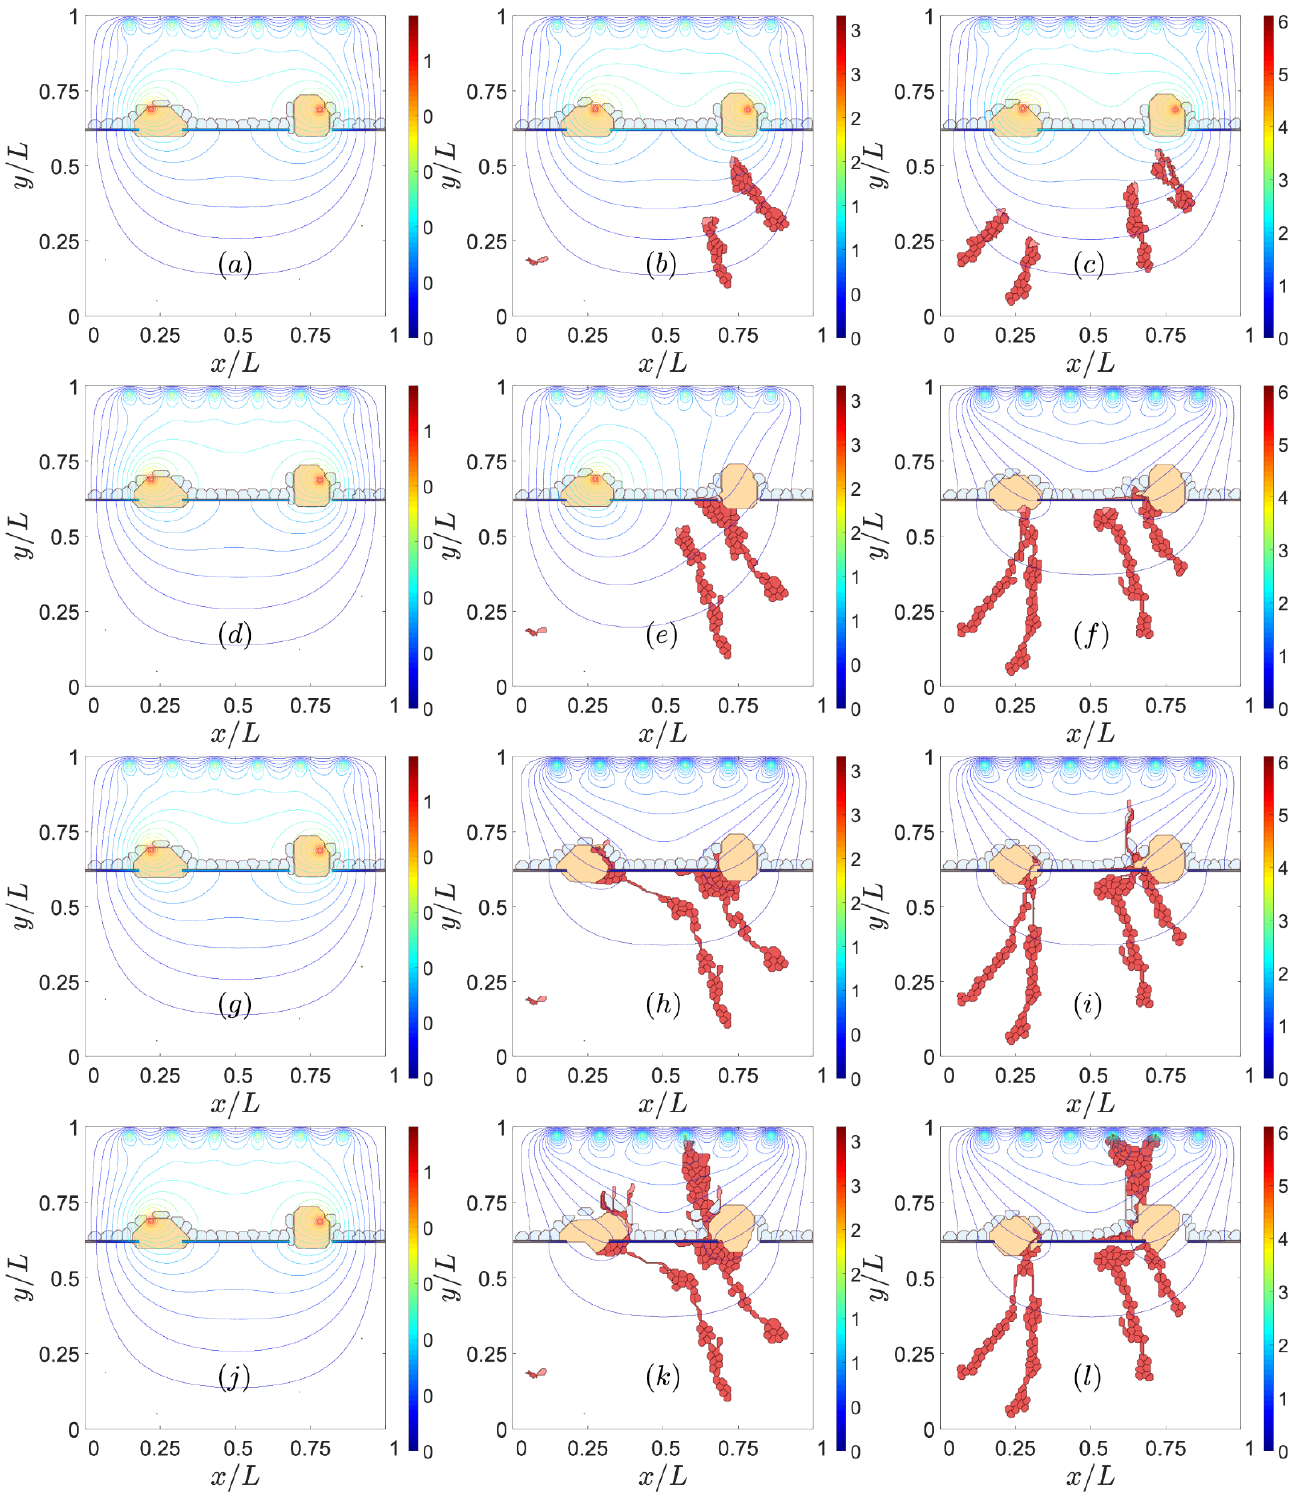
Figure 4. Effect of the VEGF concentration at the sources. For α i = 4.01 × 10 − 4 = 0.000401, snapshots at times: ( a ) 601 MCTS, ( d ) 1201 MCTS, ( g ) 3001 MCTS, ( j ) 5201 MCTS. For α i = 1.203 × 10 − 3 = 0.001203, snapshots at times: ( b ) 601 MCTS, ( e ) 1201 MCTS, ( h ) 3001 MCTS, ( k ) 5201 MCTS. For α i = 2.005 × 10 − 3 = 0.002005, snapshots at times: ( c ) 601 MCTS, ( f ) 1201 MCTS, ( i ) 3001 MCTS, ( l ) 5201 MCTS.